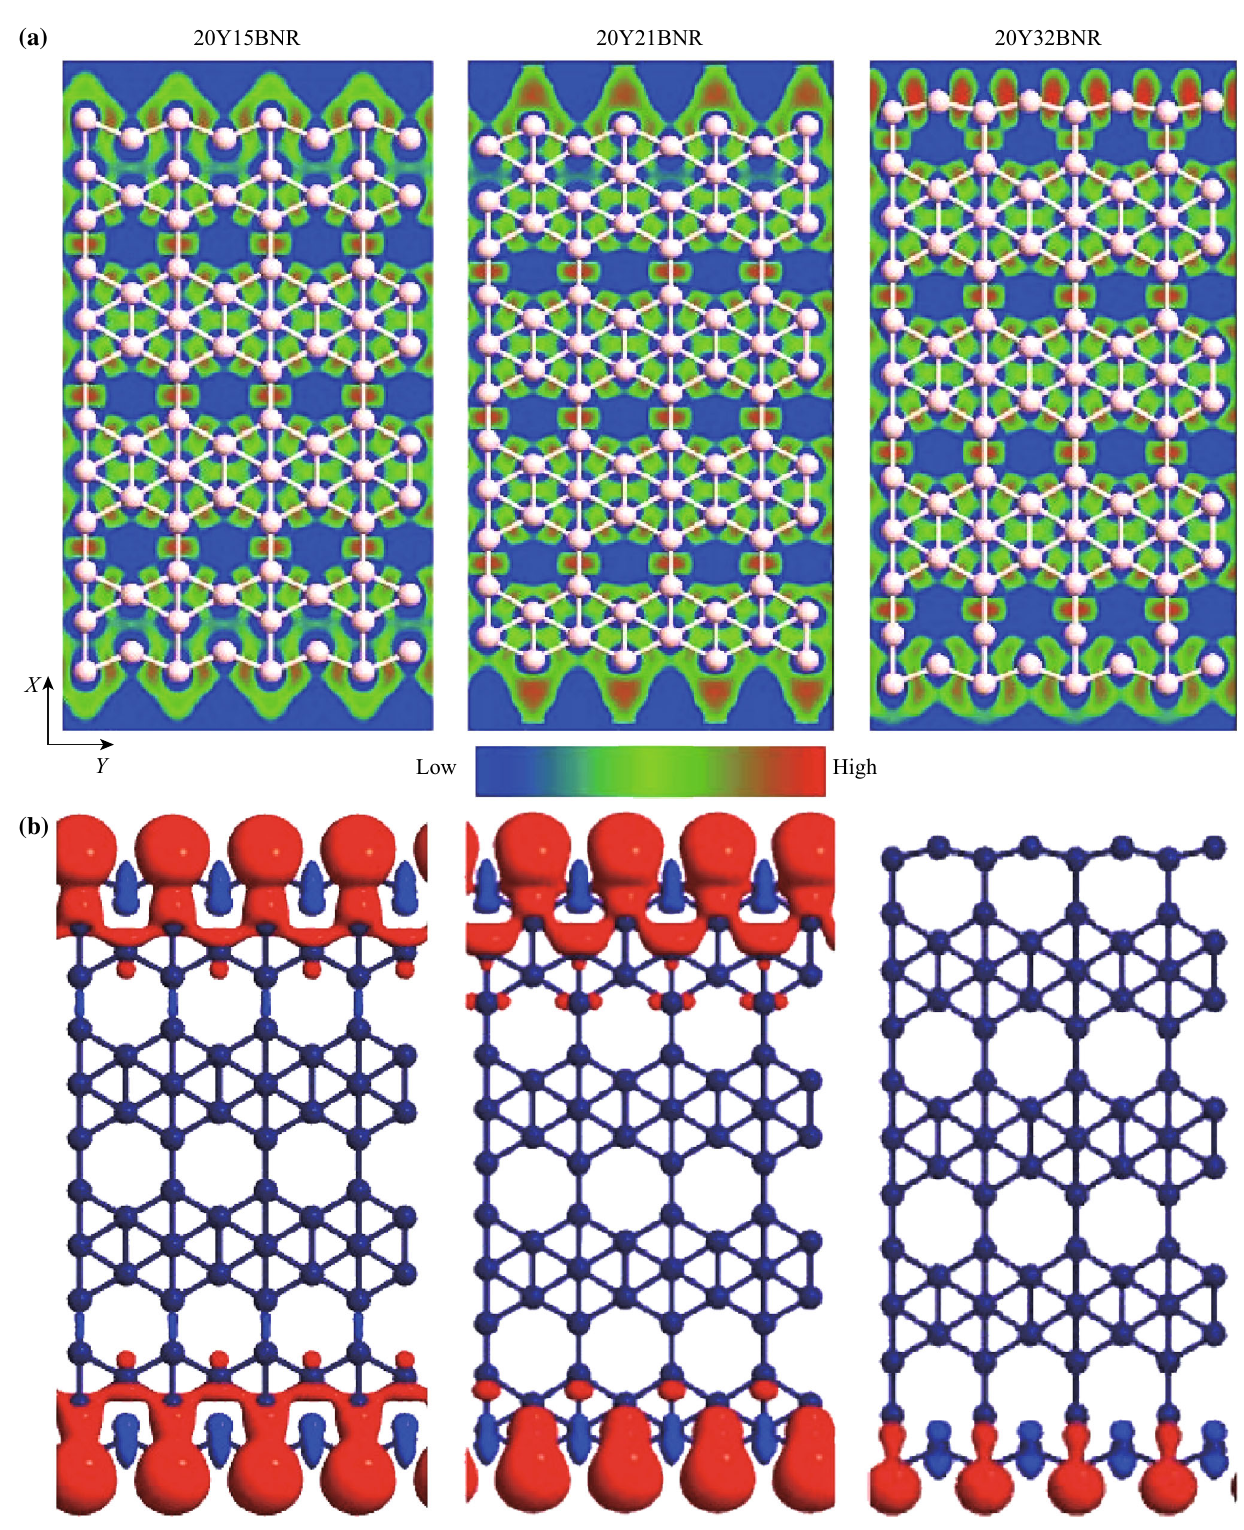
Fig. 8 a The electron localization function and b the spin density of 20YBNR allotropes. The isovalue is